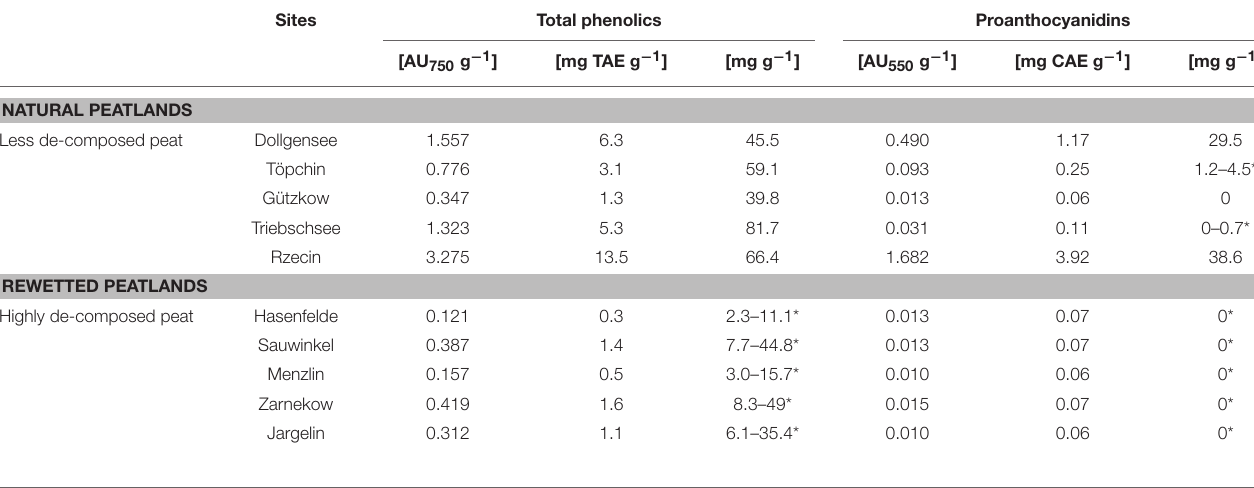
TABLE 3 | Total phenolics and proanthocyanidins in differently decomposed peat soils referring to dry mass. Sites Total